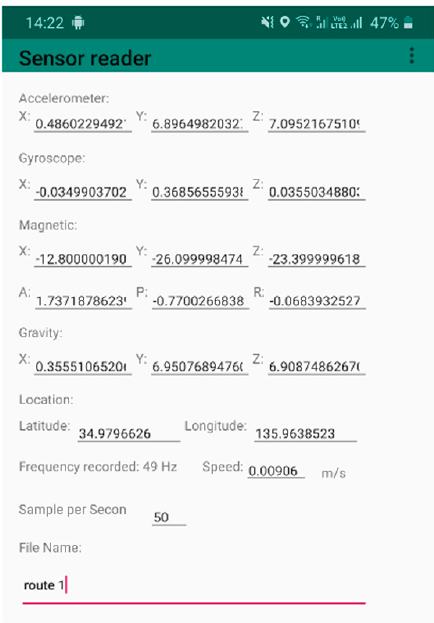
Figure 6. Data acquisition routes (marked with red) in Malang, Indonesia. (Map data copyright by OpenStreetMap contributors; available from https://www.openstreetmap.org/#map=16/- 7.9383/112.5941, accessed on 14 March 2021).